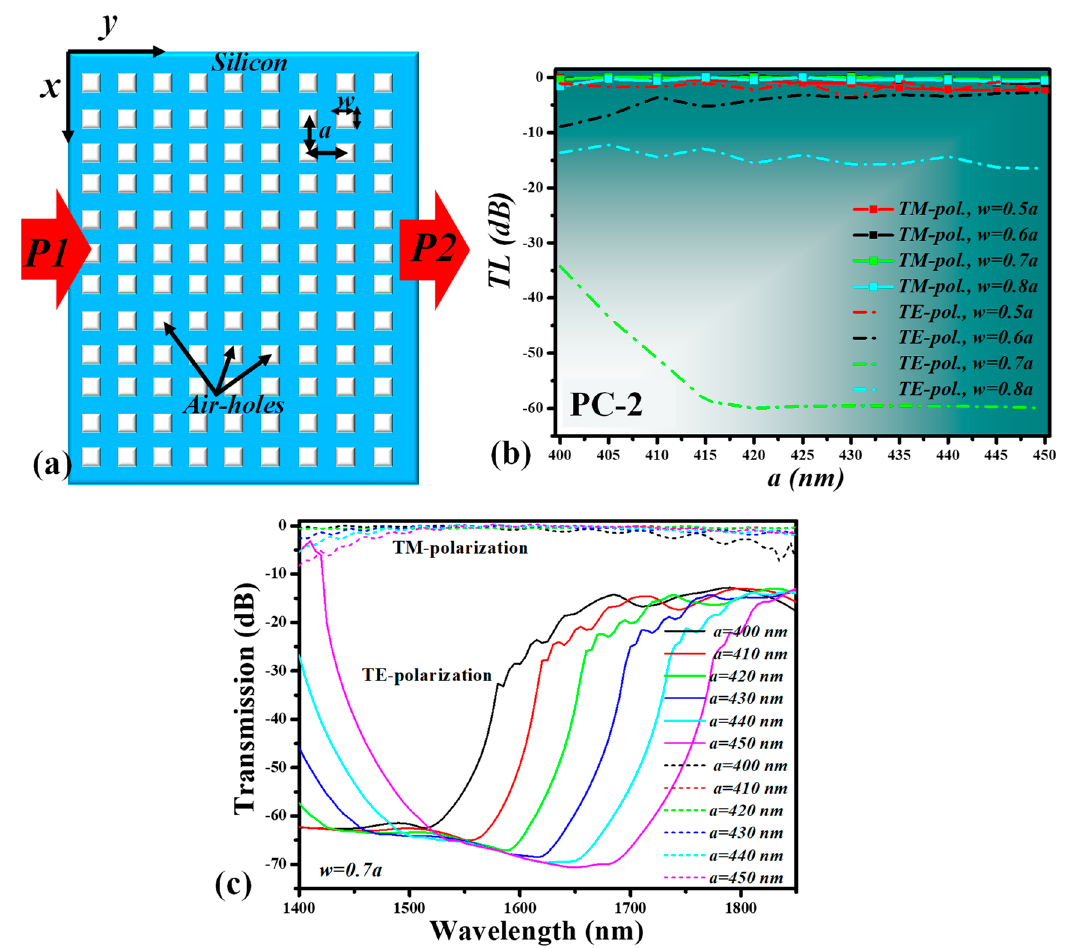
Figure 3. ( a ) Graphical representation of PC-2 formation. ( b ) The TL of TE- and TM-polarized light travelling in PC-2 formation at λ = 1550 nm. ( c ) Transmission of TE- and TM-polarized light for the wavelength range of 1400 to 1850 nm.